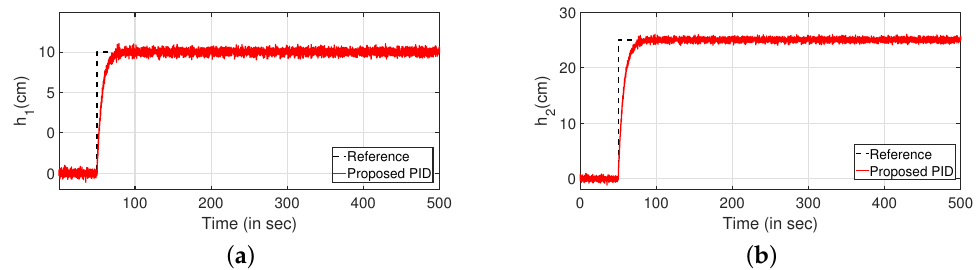
Figure 16. Reference tracking for PI controller with input uncertainties. ( a ) Level Variation in tank 1. ( b ) Control output. ( c ) Level Variation in tank 2. ( d ) Control output.